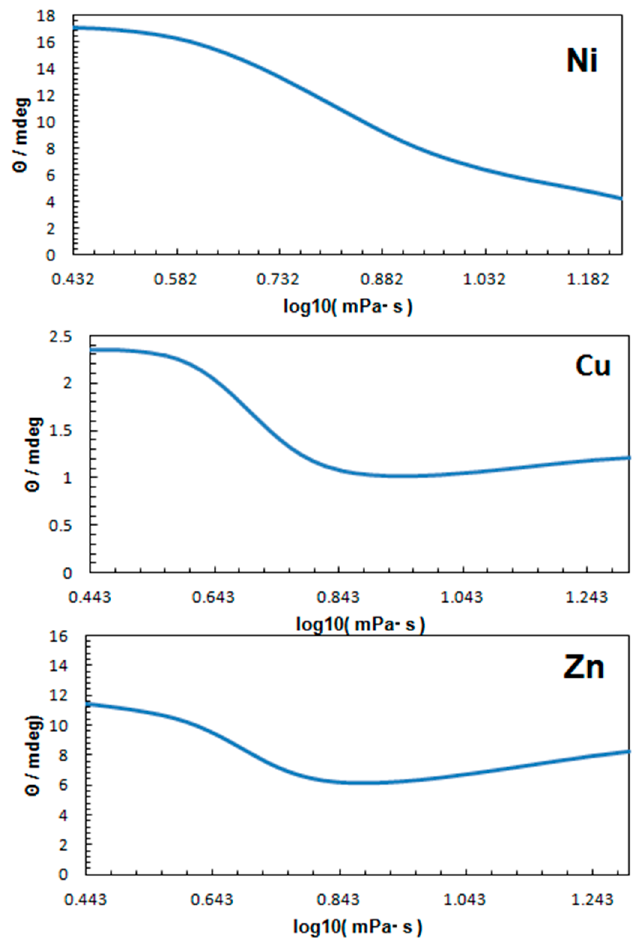
Figure 6. Correlation between concentration of PMMA acetone solutions Ni , Cu , or Zn and the intensity of artifact CD peaks.